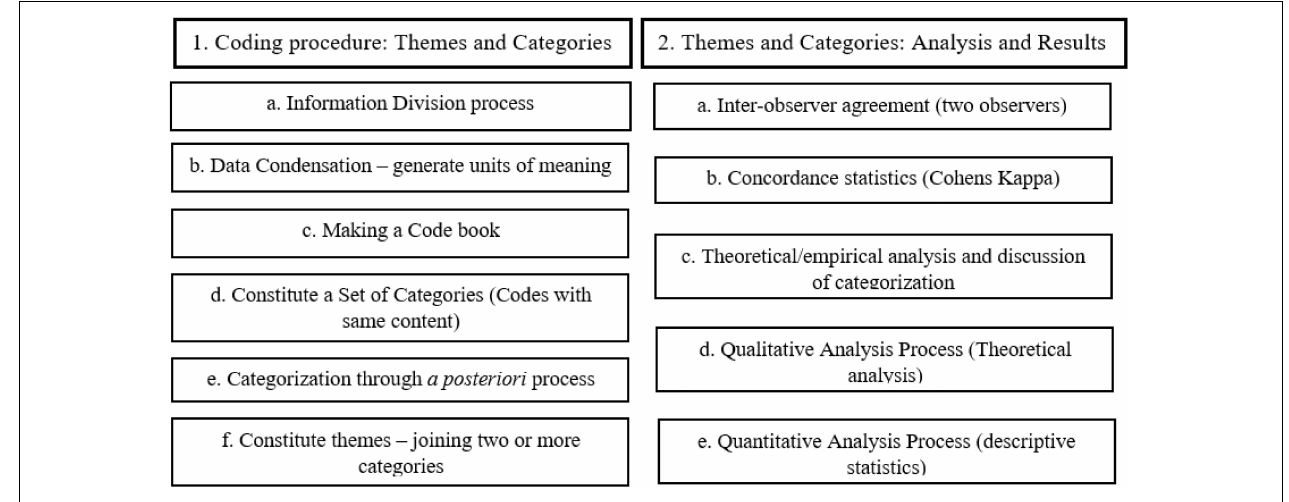
FIGURE 1 | Adapted process of content